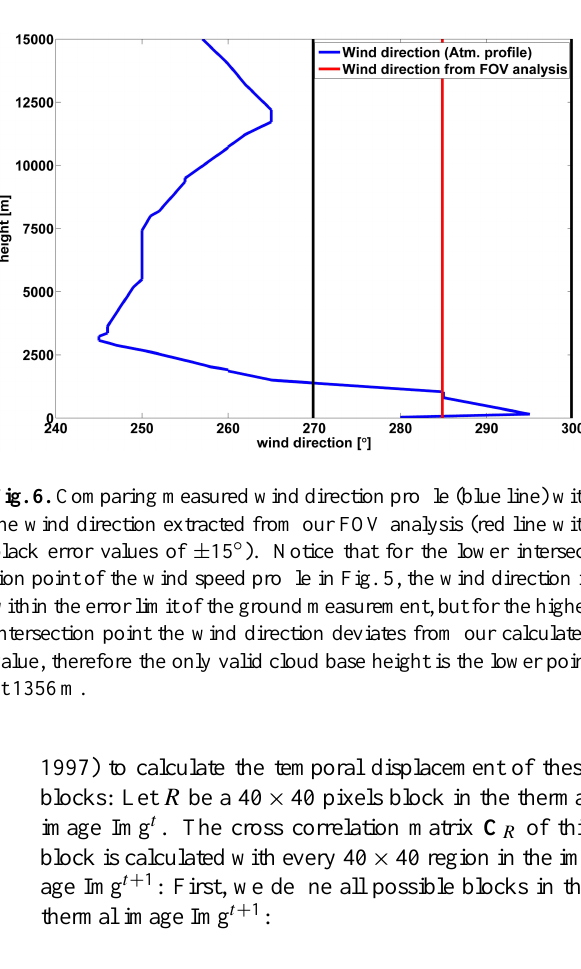
Fig. 5. Intersecting theoretical possible wind speed profile derived from FOV (field of view) analysis (red line wrapped with green error limits), with wind speed profile measured by a radiosonde in a nearby station at Beit-Dagan (blue line). The heights at which these two lines intersect mark the possible heights of the clouds layer. Left: profile range 0–15km. Right: zooming on 1250–1400m. The black line is the relative humidity profile (notice how the lower crossing point at 1356m corresponds to a sharp increase in the RH). the magenta line is the LCL height (1294m) as derived by the radiosonde data (Bolton, 1980). The cyan line is the cloud base height (1311m) extracted by a nearby ceilometer (Website: “Station Observations”).